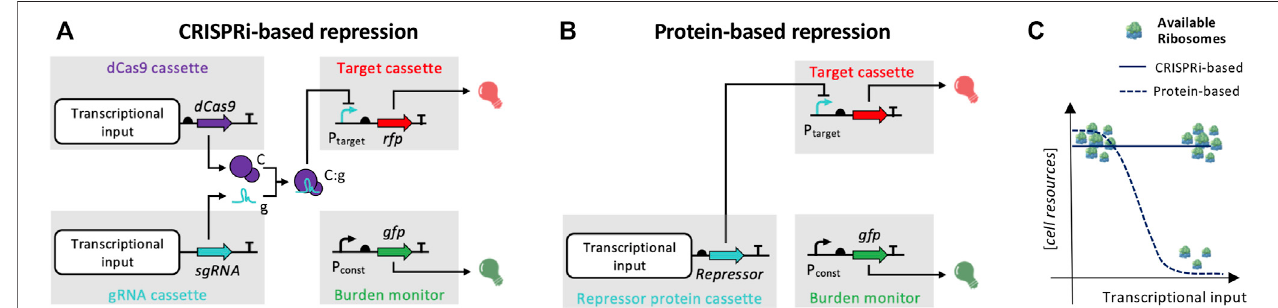
FIGURE1| Architectureofthecircuitcollectionusedinthisworkandcomparisonwithtraditionalproteinrepressor-basedcircuits. (A) Fourmodulesareillustrated: dCas9,sgRNA,RFPandGFPexpressioncassettes.Straightarrowsrepresentprotein-codinggenesorsgRNA,curvedarrowsrepresentpromoters,halfovalsrepresent ribosome binding sites, and T shapes represent transcriptional terminators. Thin truncated arrows represent repression, while red and green bulbs indicate fl uorescent outputs. The C , g and C:g symbols correspond to the dCas9 protein, sgRNA molecule and their complex, respectively, with the same representation as in the mathematicalmodel.GenerictranscriptionalinputsareshownforthedCas9andsgRNAcassettes,whichmaybeprovidedbyconstitutiveorinduciblepromoters.P const is the J23100 promoter which drives the constitutive expression of GFP in the cell load monitor cassette, and P target is the P LtetO1 , P LlacO1 or the P luxRep promoter. CRISPRi-based logic inverters conform to the illustrated circuitry: they have a tunable transcriptional input driving sgRNA expression, and a constitutive cassette for dCas9production. (B) Architectureofatraditionalproteinrepressor-basedlogicinverter,shownforcomparison:agenecodingforarepressorproteinisexpressedbya generictranscriptionalinputandbindsatargetpromoter.Symbolsarethesameasinpanel (A) . (C) ExpecteddifferencebetweenCRISPRi-andproteinrepressor-based logic inverters in terms of cellular resource usage asa function of the transcriptional input. The expression ofrepressor protein can exert an input-dependent load for the host, overloading the translational machinery. Conversely, changes of sgRNA expression do not affect ribosome availability, which is expected to be poorly affected, assuming that dCas9 expression is optimized to guarantee a low impact on translational resources during circuit